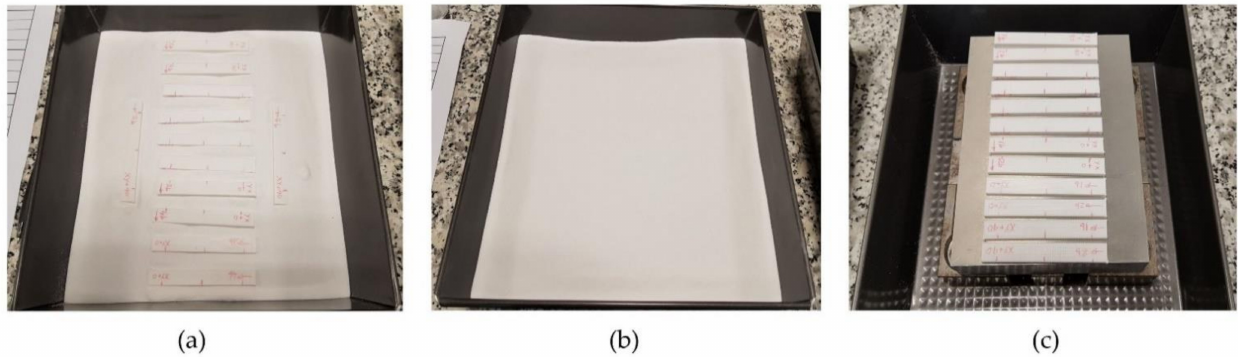
Figure 4. ( a ) Samples set inside of the mould over a powder layer of 1 cm; ( b ) upper alumina powder layer of 1 cm covers samples; ( c ) samples set outside the mould, over the 7 kg metal